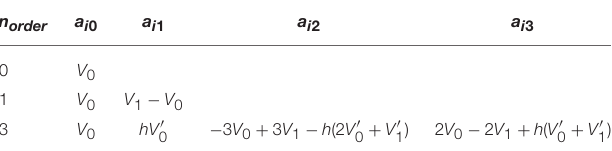
TABLE 1 | Coefficients of the interpolation polynomial depending on the interpolation